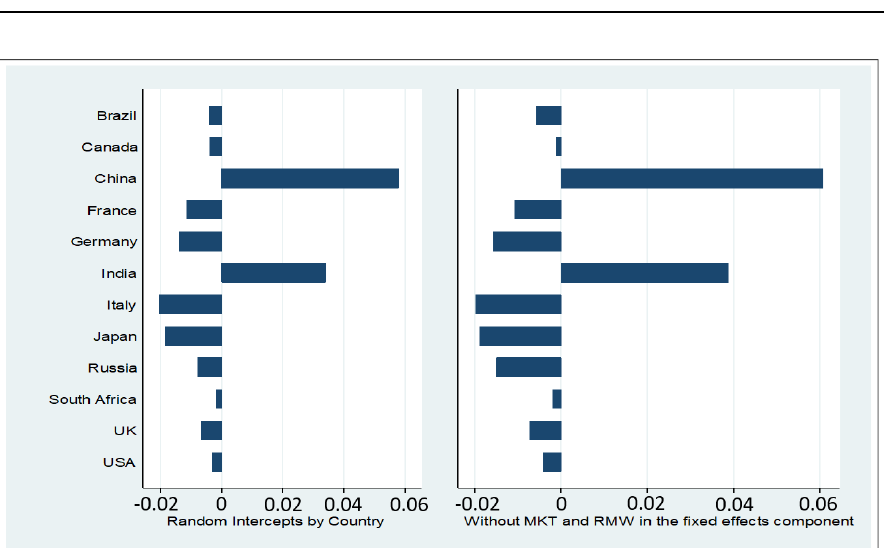
Figure 4. Expected values of random effects intercepts by country estimated by the linear trend model with and without the explanatory variables MKT and RMW in the fixed effects component.